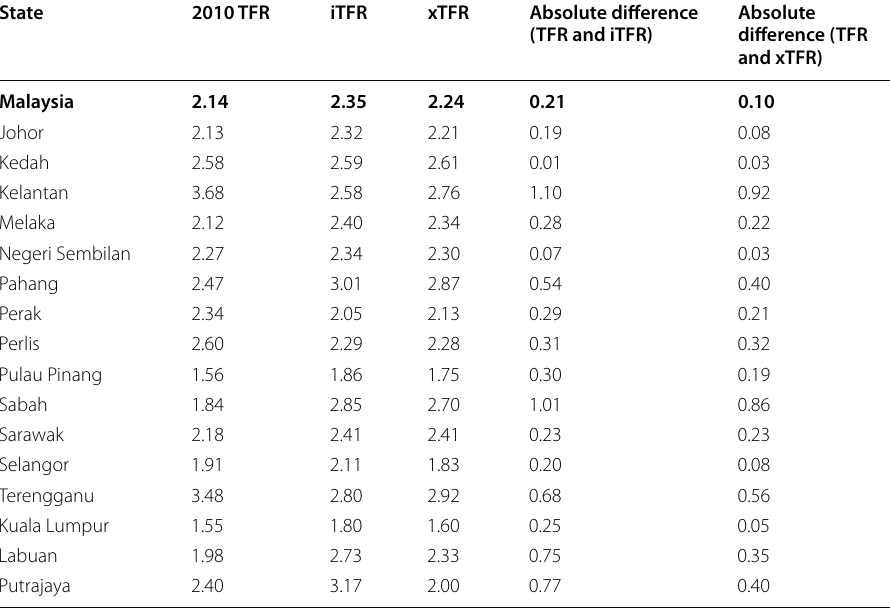
The bold values show the overall values for Malaysia (country as a whole) and Sabah (state as a whole) The iTFR and xTFR were computed using Eqs. (3) and (4),